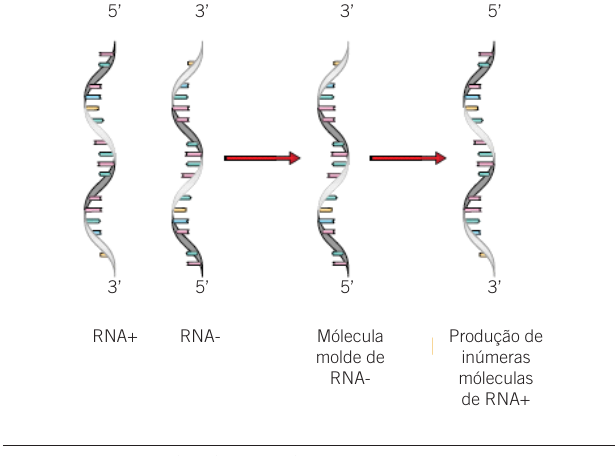
FIGURA 4 – Adesão do vírus à membrana celular Fonte: Instituto Oswaldo Cruz (IOC/Fiocruz).